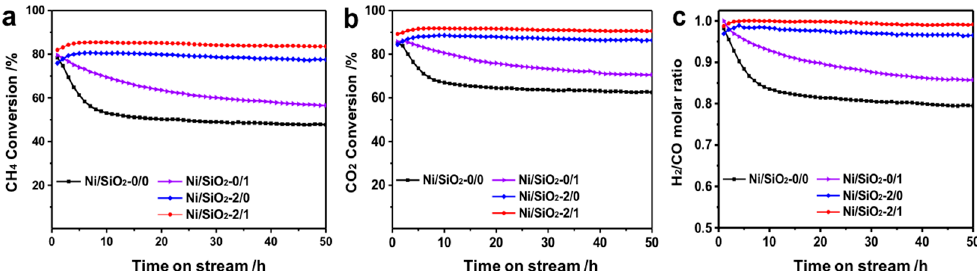
Figure 2. CH 4 conversion ( a ), CO 2 conversion ( b ), and H 2 /CO molar ratio ( c ) as a function of time on stream for Ni/SiO 2 catalysts prepared with the combustion method at different molar ratios of C 2 H 5 NO 2 to NH 4 NO 3 (black line: conventional wetness impregnation method; purple line: NH 4 NO 3 only; blue line: C 2 H 5 NO 2 only; red line: 2/1 ratio of C 2 H 5 NO 2 to NH 4 NO 3 ). The reaction was carried at 800 ◦ C with 200 mg of catalyst and a molar ratio of CH 4 /CO 2 /N 2 = 9/9/2 with 160 mL/min.